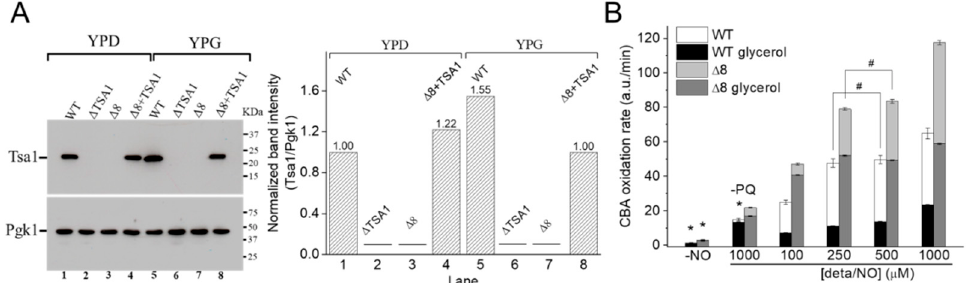
Figure 6. CBA oxidation in suspensions of glycerol-adapted WT and ∆ 8 S. cerevisiae cells. ( A ) Immunoblotting and comparative densitometry of the Tsa1 in selected strains grown in YPD and YPG mediums. ( B ) The rate of CBA oxidation of control and glycerol-adapted WT and ∆ 8 S. cerevisiae cells. CBA (10 µ M), paraquat (10 µ M), and increasing concentrations of deta / NO were added to 96-well plates containing 20 × 10 6 WT or ∆ 8 S. cerevisiae cells per well. Experimental conditions and